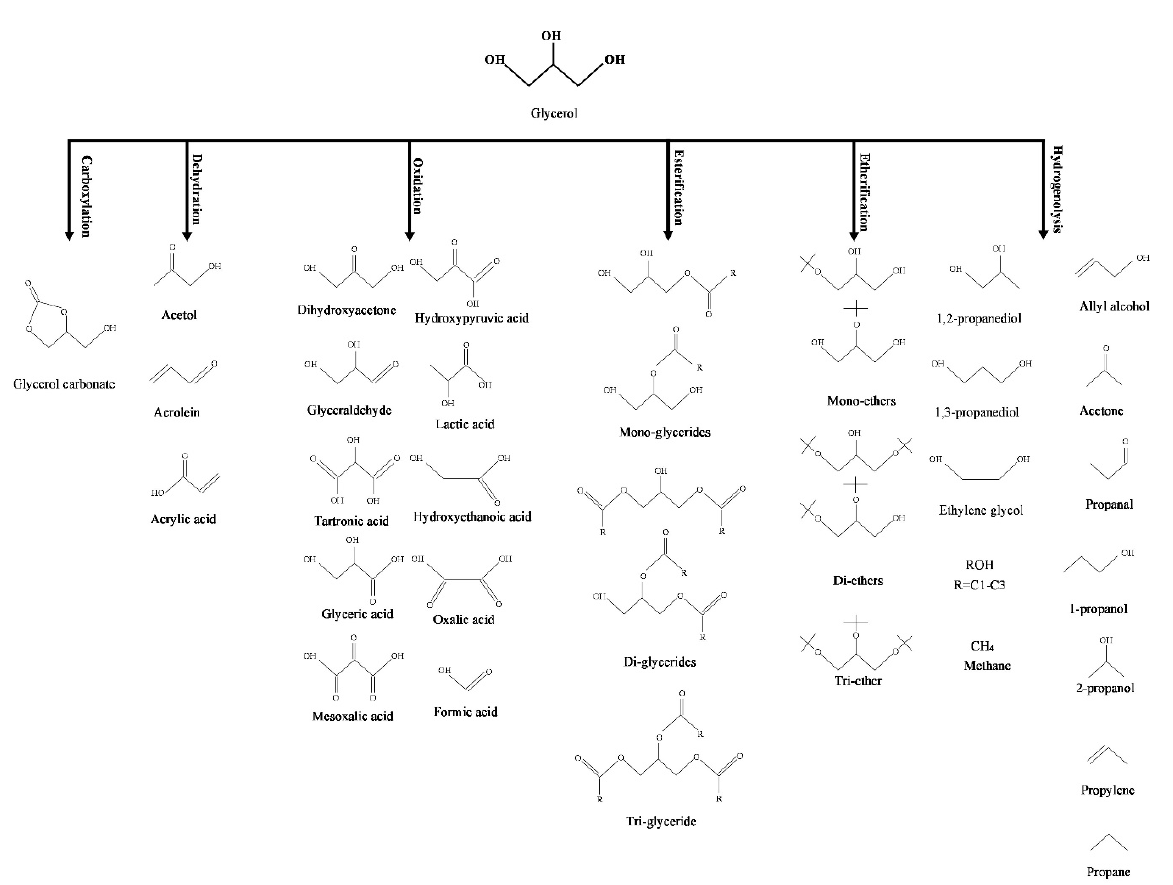
Figure 3. Main glycerol derivatives through different pathways.